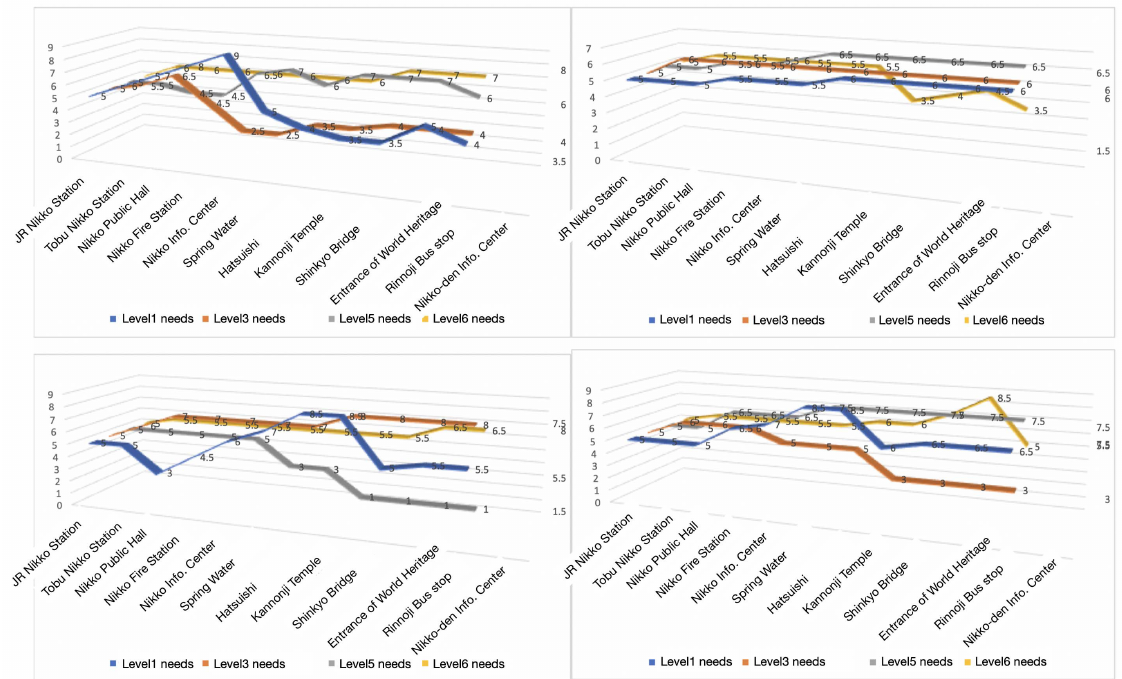
Figure 19. History of changing the value of the reference points: Experiment